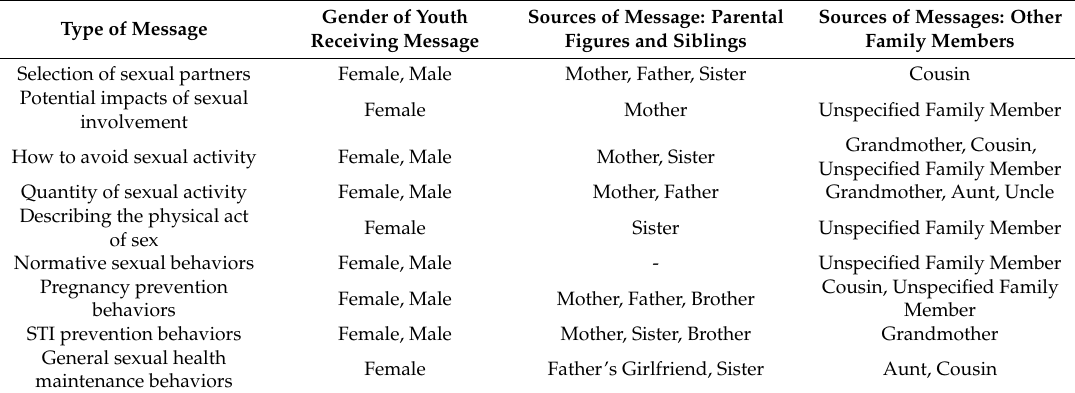
Table 1. Types and Sources of Message Received about Sex and Sexual